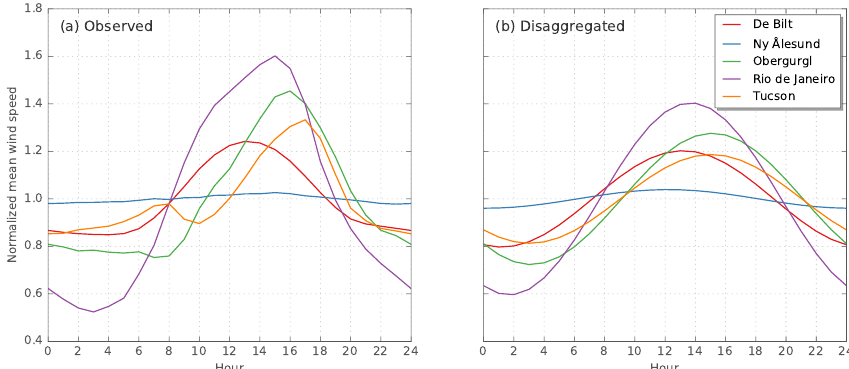
Figure 11. Long-term averages of diurnal courses of (a) observed and (b) disaggregated “normative” wind speed (W2 model). The normative wind speed indicates the ratio of the long-term mean of the wind speed observed or modelled at a specified hour to the respective value averaged for the entire day. The period of time involved in this analysis is listed in Table 1 for each station.